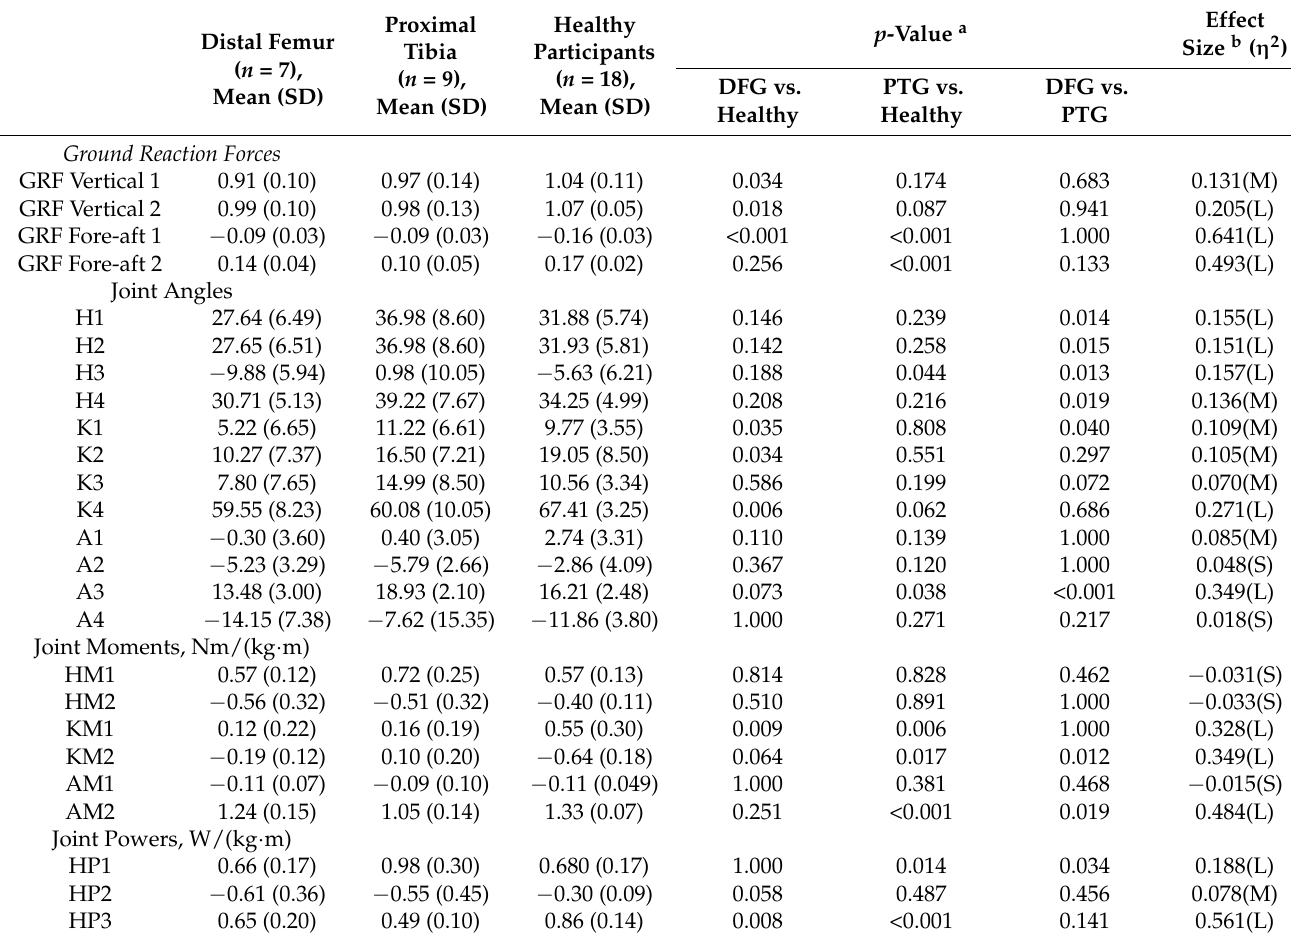
Figure 1. Ground reaction forces. The red lines represent mean values for the distal femur group. The blue lines represent mean values for the proximal tibia group. The dashed lines represent the healthy subjects. * Statistically significant for the comparison between distal femur group and healthy subjects. ** Statistically significant for the comparison between proximal tibia group and healthy subjects. Table 5. Comparison of kinetic and kinematic parameters between patients and healthy participants.